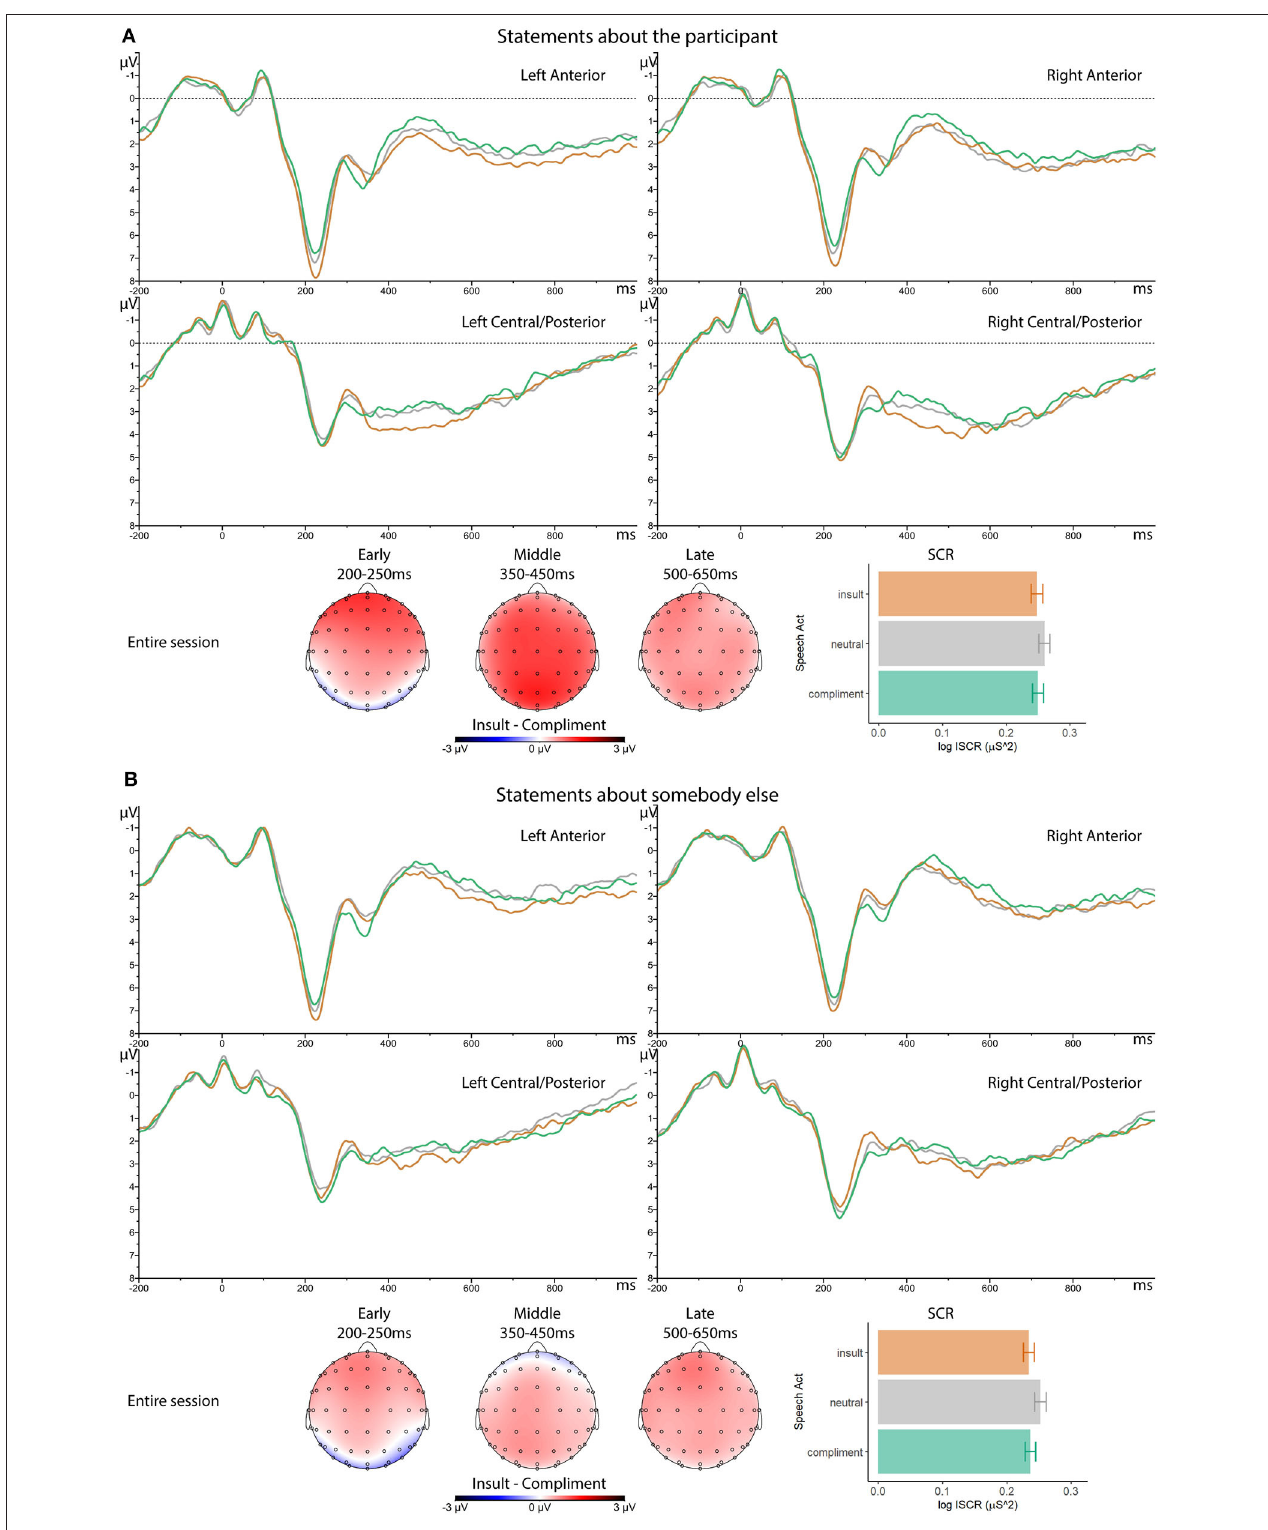
FIGURE 4 | Observed effects of speech act as a function of who is being described. Grand average ERP waveforms ( µ V, negative up) in four scalp regions for insults, compliments and neutral descriptions, scalp distribution of the insults minus compliments differential ERP effect in three latency ranges of interest ( µ V, three left topographical maps), and the grand average event-related whole-trial skin conductance response (log ISCR 2 , right bar graph) for insults, compliments and neutral descriptions, all across the entire session, for (A) statements about the participant and (B) statements about somebody else.